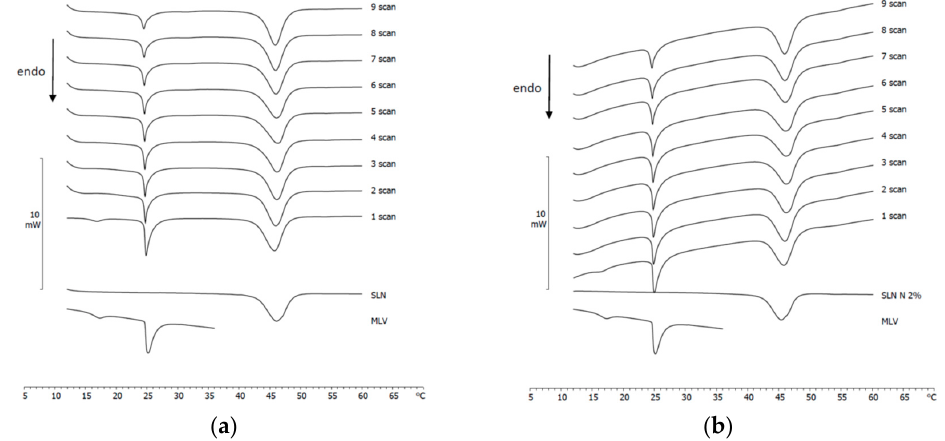
Figure 6. ( a ) Calorimetric curves, in heating mode, of MLV left in contact with unloaded SLN. The calorimetric curves are compared with the calorimetric curves of MLV and SLN. ( b ) Calorimetric curves, in heating mode, of MLV left in contact with 2% Naringein-loaded SLN. The calorimetric curves are compared with the calorimetric curves of MLV and 2% Naringenin-loaded SLN.